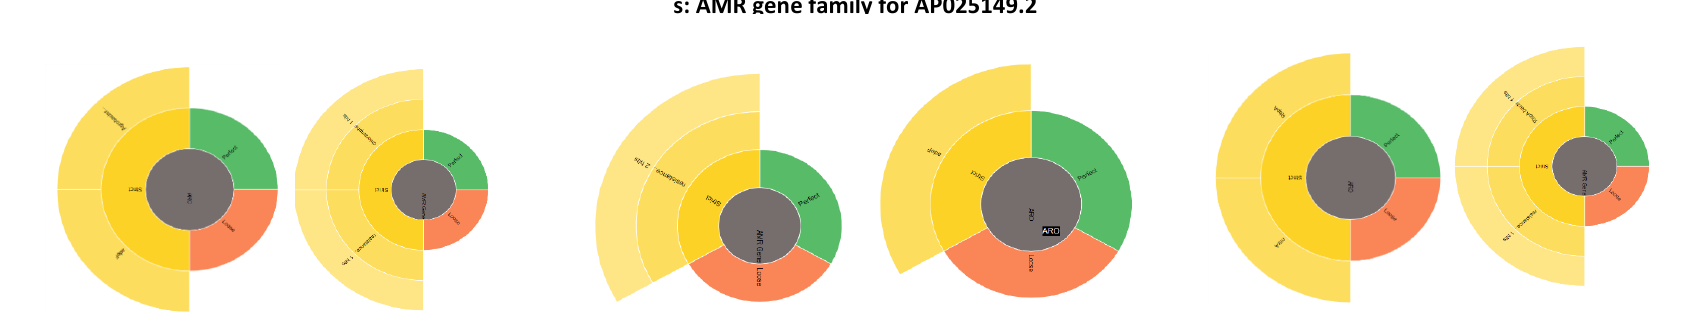
t: AMR gene family for CP000438.1 u: AMR gene family for CP019702.2 Figure 1. ARO classification tags for the selected twenty-two PGRD bacteria a-v: The assemly contigs retains the RGI into perfect (green), strict (flexible )and loose( spurious partial) resistomes.